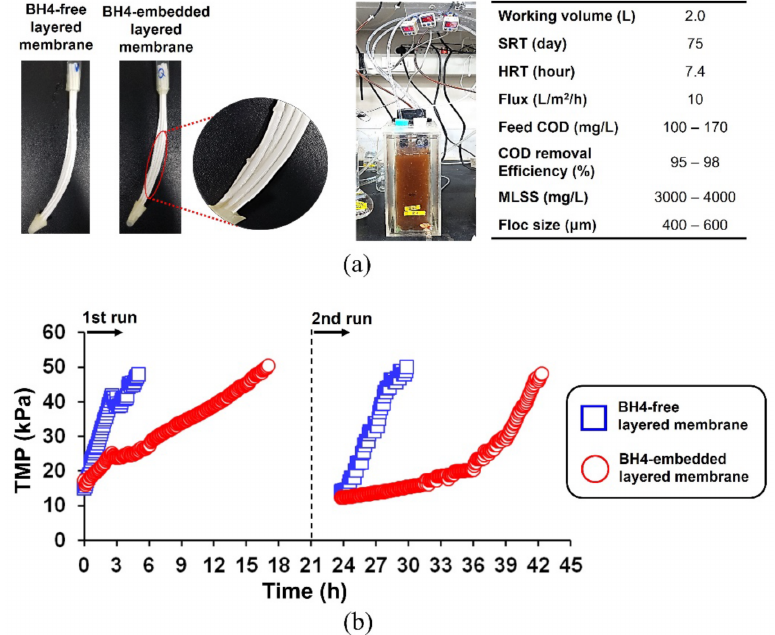
Figure 5. Application of BH4-free and BH4-embedded layered membranes in MBRs. ( a ) Images of BH4-free and BH4-embedded layered membrane modules used for laboratory MBRs, which were operated under the given conditions. ( b ) TMP profiles of two types of layered composite membranes. New membrane modules were employed for each